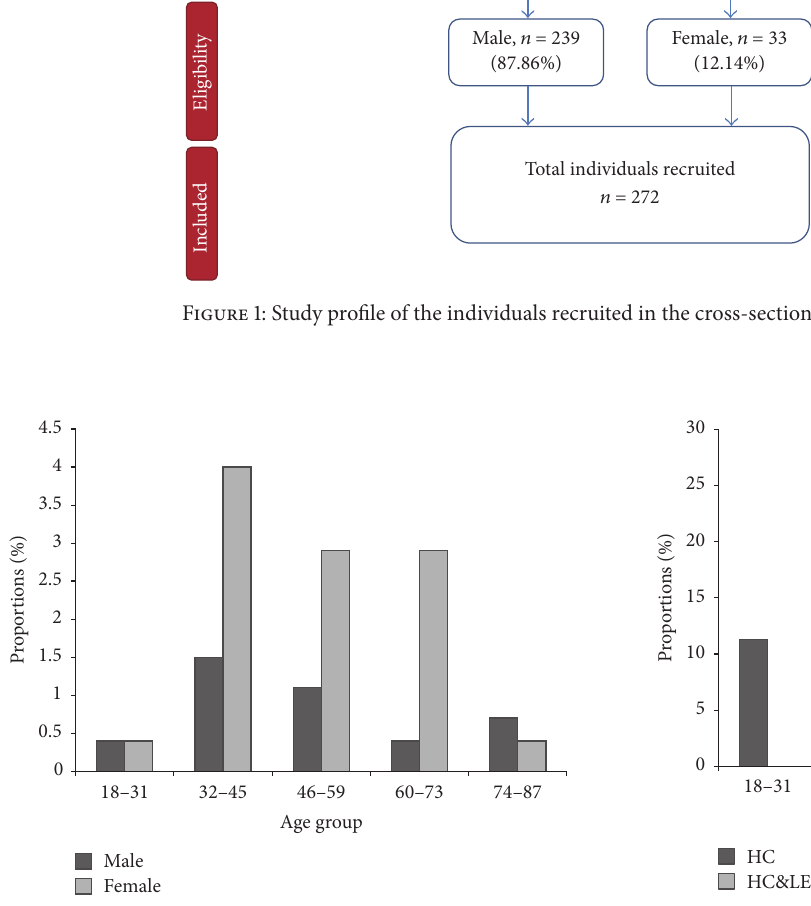
Figure 2: Age distribution of lymphoedema pathology according to stages in the examined individuals.